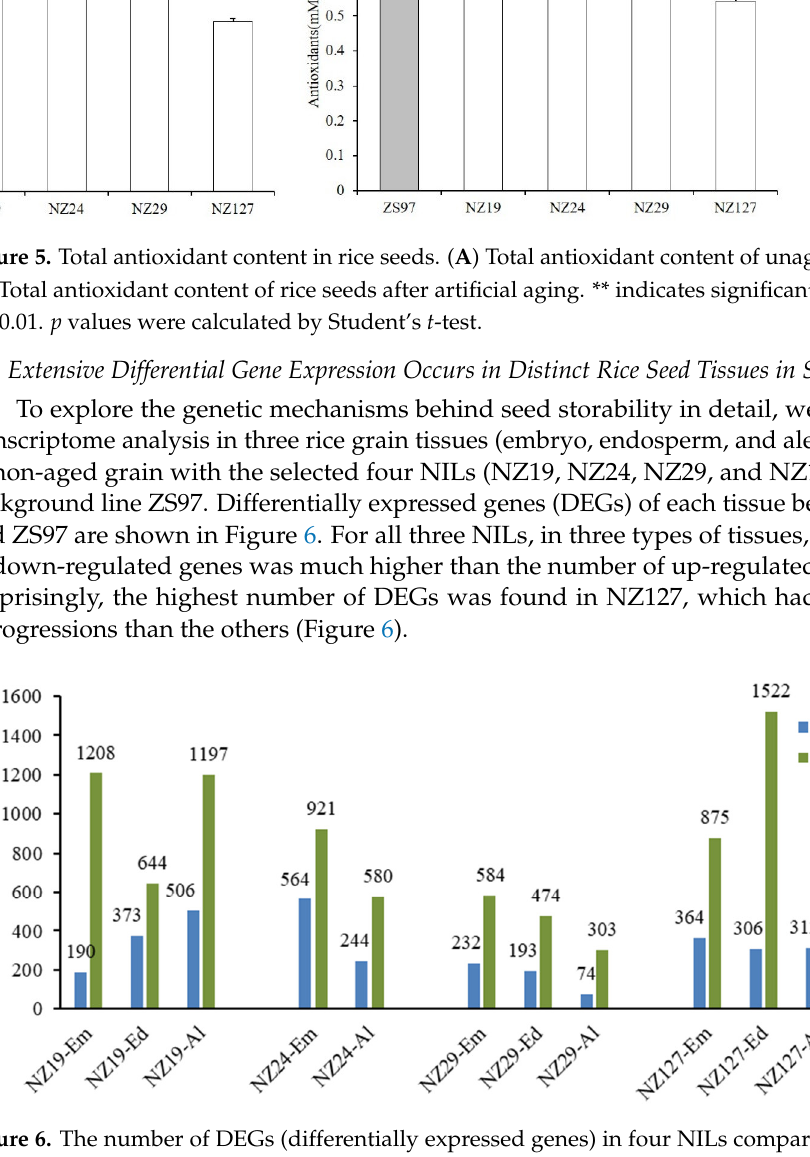
Figure 6. The number of DEGs (differentially expressed genes) in four NILs compared with ZS97. Em, Ed and Al represent embryo, endosperm, and aleurone